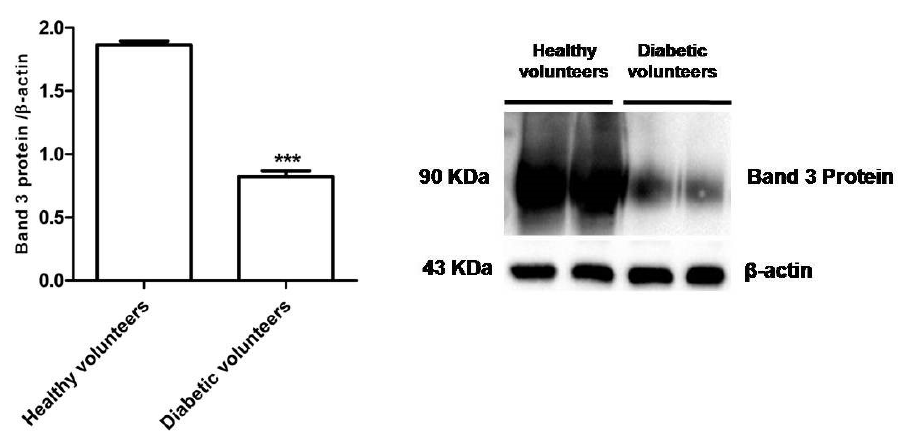
Figure 4. Expression levels of Band 3 protein measured in erythrocytes from healthy volunteers (control) or in diabetic volunteers detected by Western Blot analysis. *** p < 0.001 versus control as determined by the Student’s t -test ( n = 5).